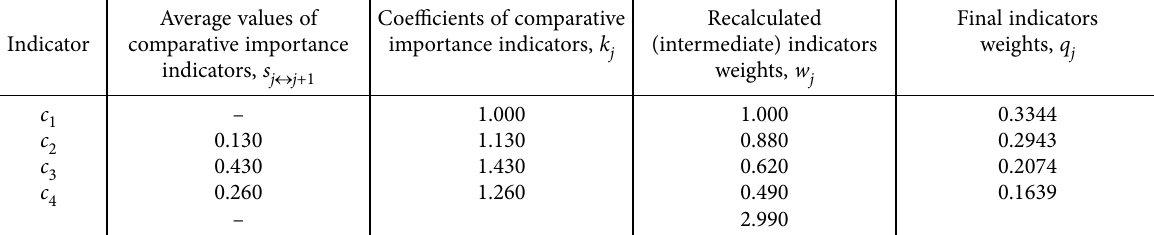
Table 4. Criteria Weighting by SWARA